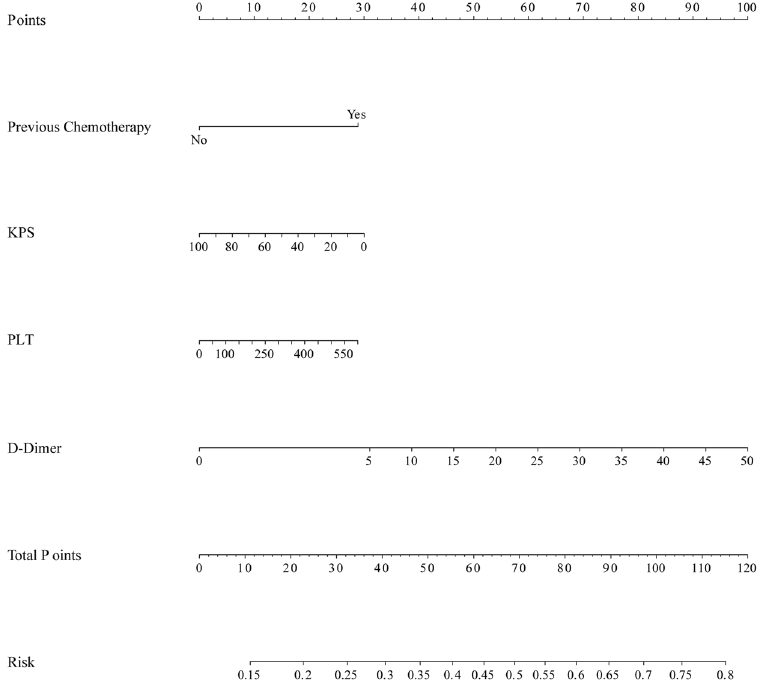
Figure 4. Nomogram predicted PICC associated thrombosis risk using the four chief characteristics.